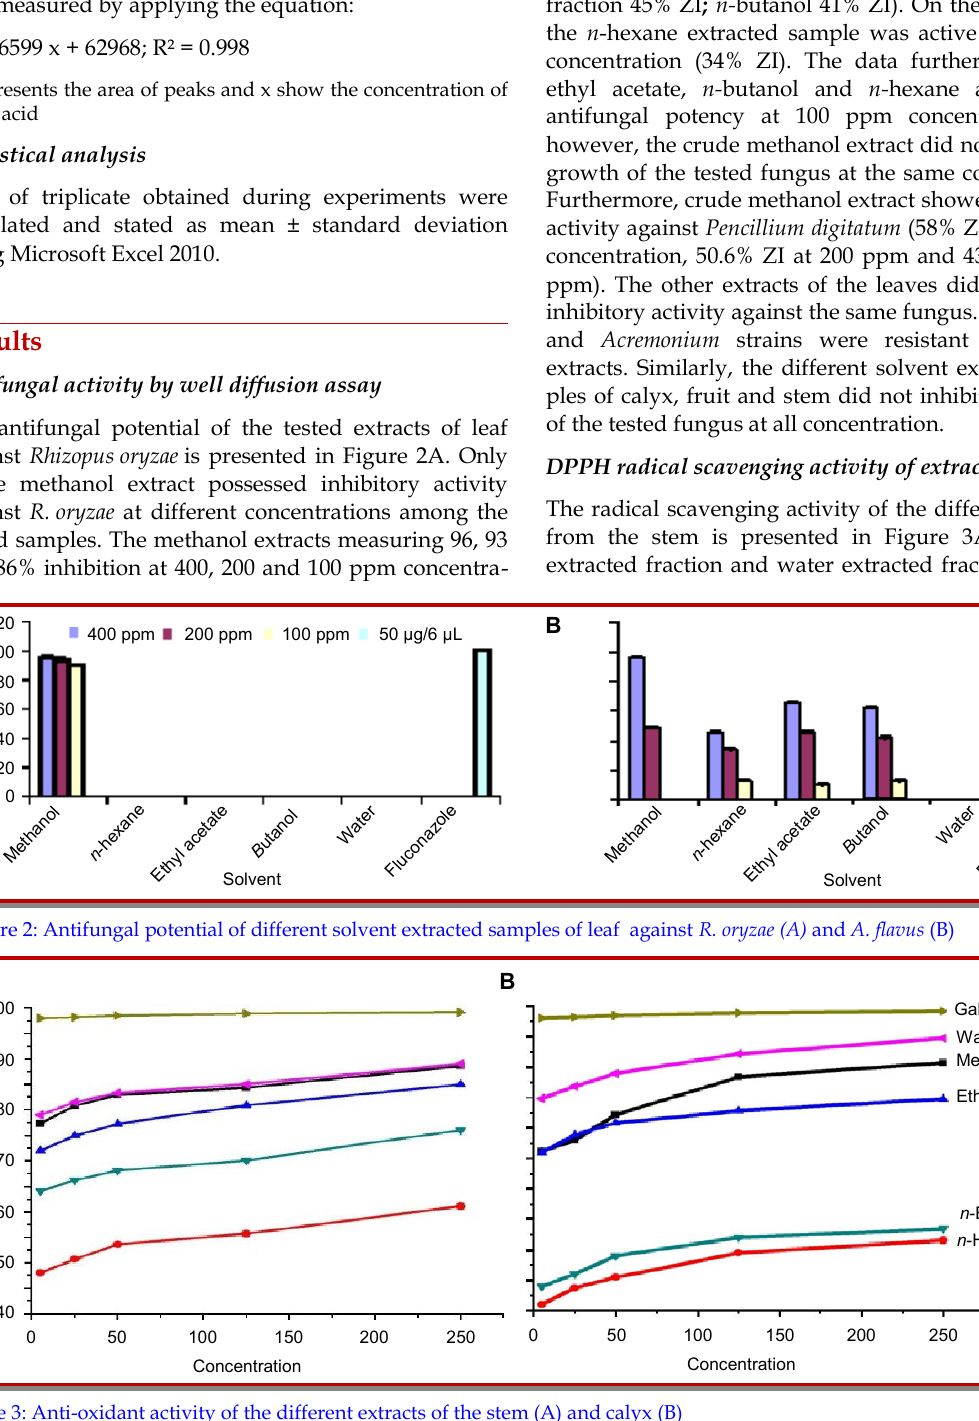
Figure 3: Anti-oxidant activity of the different extracts of the stem (A) and calyx